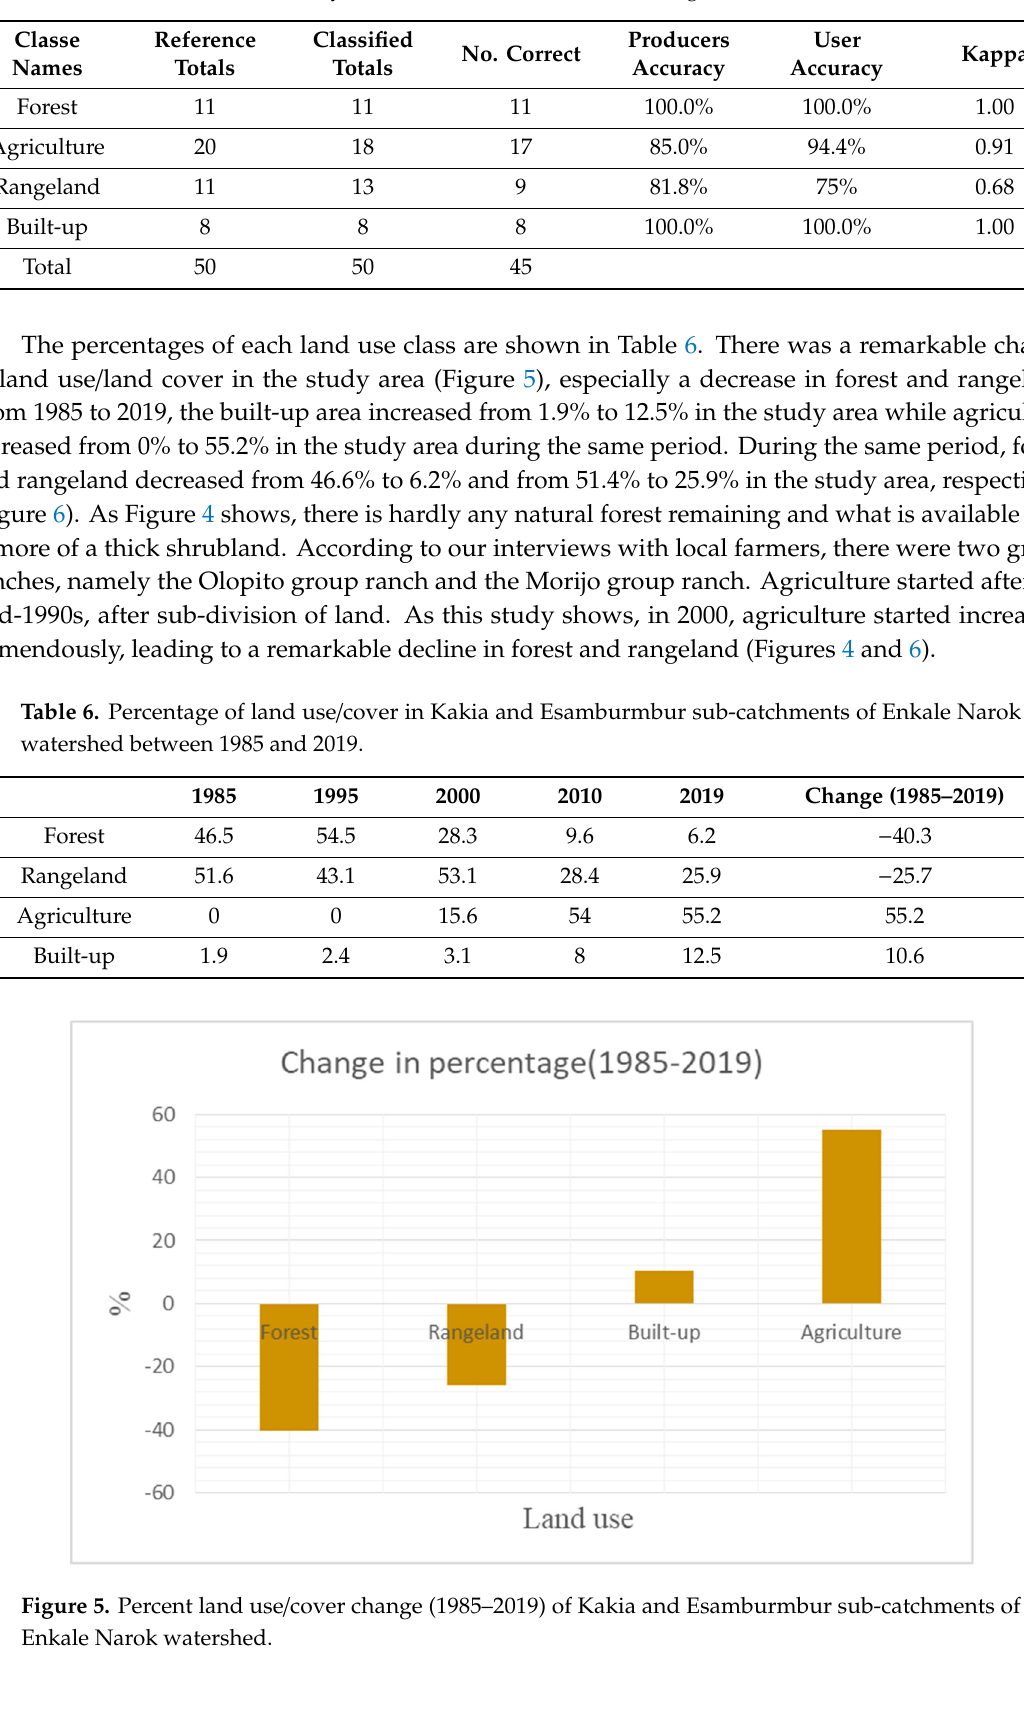
Table 5. Accuracy assessment result of classified image (12 March 2019).